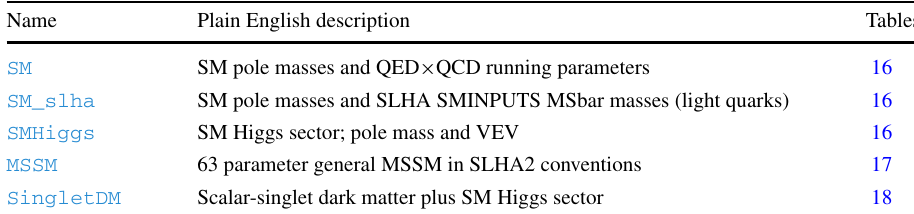
Table 12 List of available